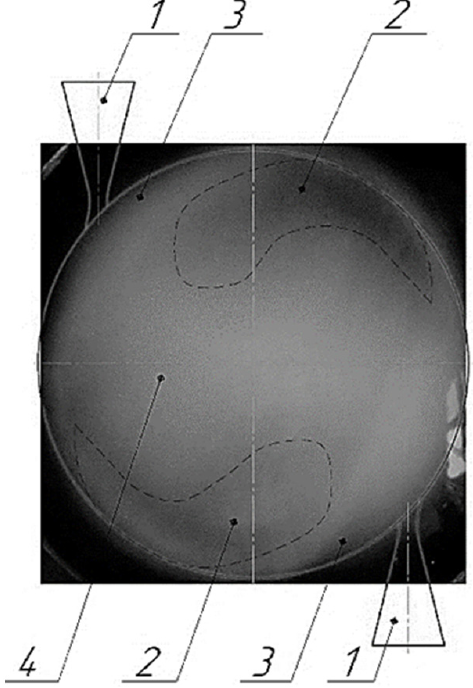
Figure 4. The uneven flow in the initial cross-section I-I of the vortex camera: 1—active flow nozzles; 2—steam zones; 3—vacuum zones; 4—a vortex of the vapor–liquid mixture.